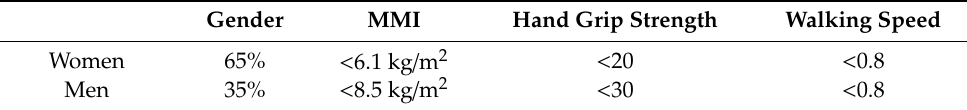
Table 1. Assessment criteria at Tijuana General Hospital [11].